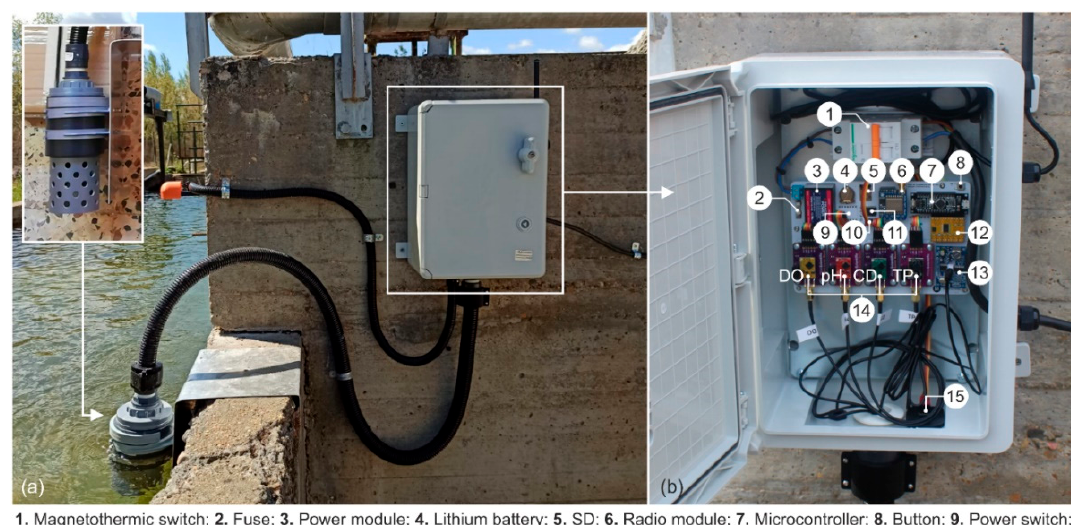
Figure 3. Final design of the node: ( a ) Node installed in the diversion channel of the facility; ( b ) Final electronic configuration. Table 2. Summary of the sensor suite in the node, together with its principal